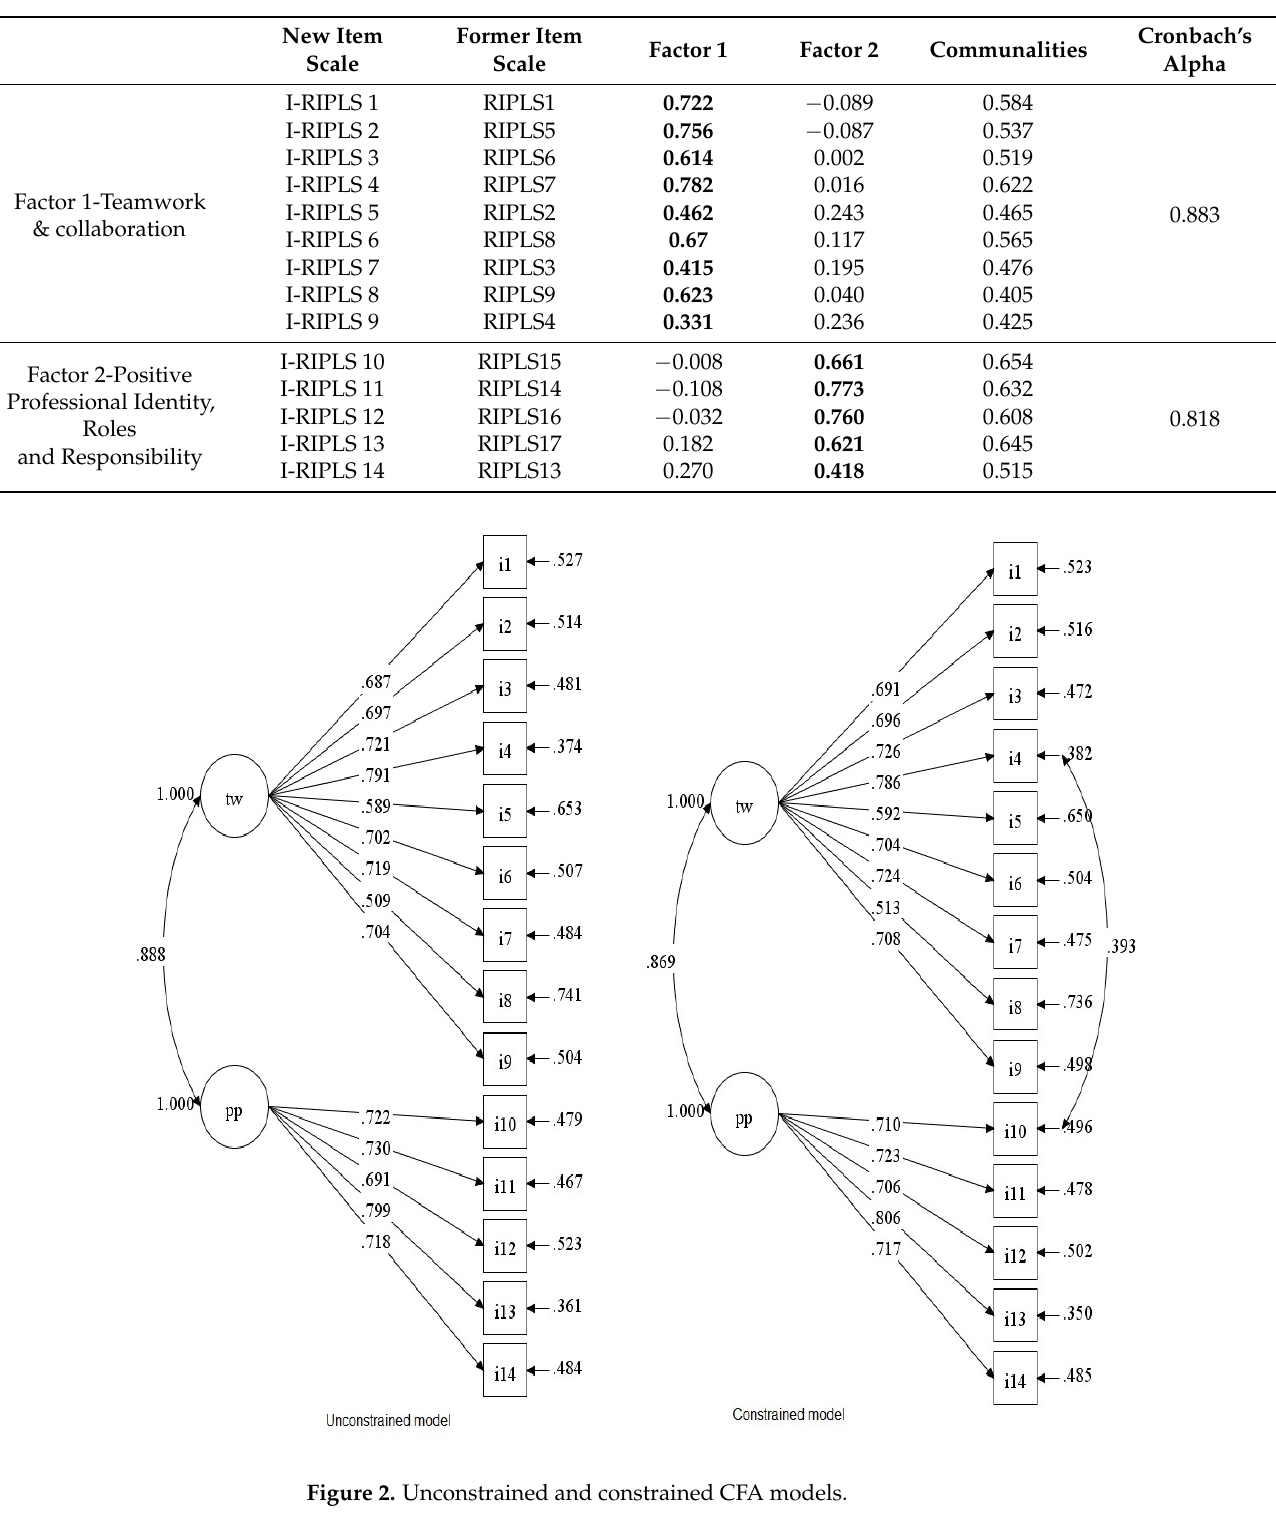
Table 5. I-RIPLS Exploratory Factor Analysis.